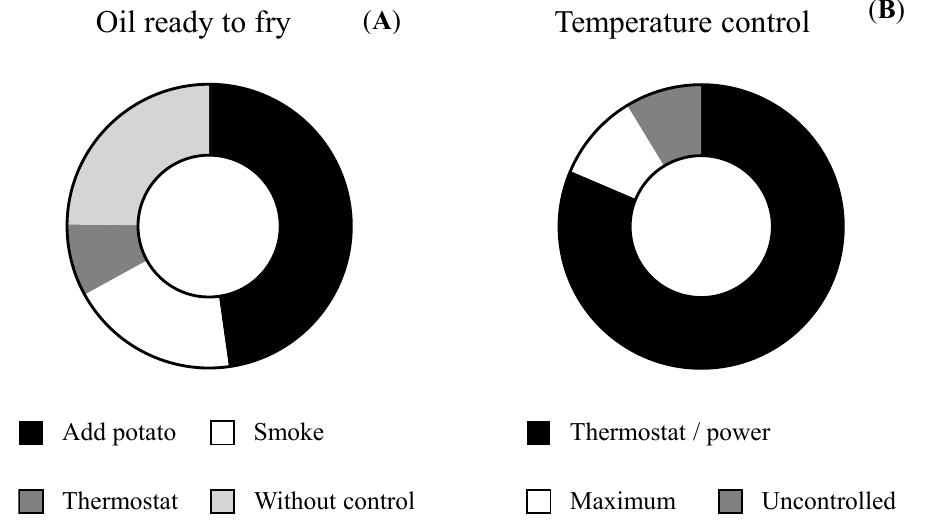
Figure 5. Selection of frying starting point ( A ) and temperature control during french fry preparation ( B ).